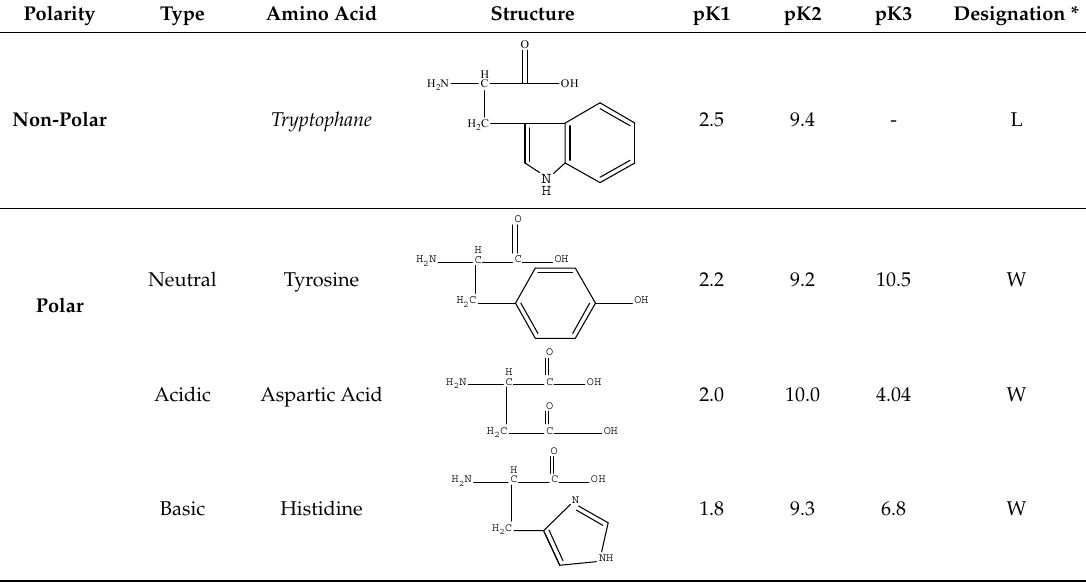
Table 1. Amino acids (AAs) selected for the study.